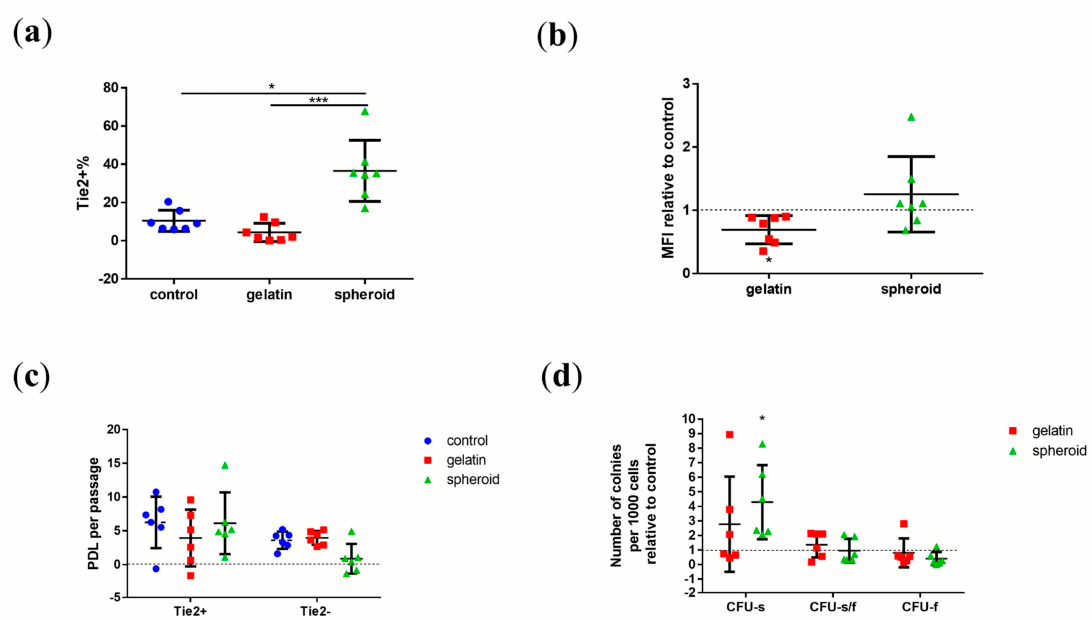
Figure 3. Plot of individual values of Tie2+ cells’ yield in the human NPC population. ( a ) Tie2-PE median of fluorescence intensity (MFI) of living single NPCs relative to control; ( b ) population doubling level (PDL) of Tie2+ NPCs and Tie2- NPCs; ( c ) and quantification of number of CFUs with resuspended NPCs relative to control in different flask types, ( d ) Number of clones with cells ≥ 10 cells per 1,000 cells seeded in methycellulose medium after ten days. Here, “control” represents cells cultured in “standard” T75 flasks, “gelatin” represents cells cultured in 0.1% gelatin-coated T75 flasks, and “spheroid” represents cells from the spheroid forming assay in ultra-low attachment T75 flasks, “number of clones relative to control” represents the number of clones formed per 1000 cells of the cells cultured in gelatin/spheroid group relative to control group; N (donors) = 7 in ( a , b ), and N = 6 in ( c , d ). Kruskal–Wallis signed-rank test with Dunn’s multiple comparison test. p = 0.0422 (a, control vs. spheroid), 0.0005 (a, gelation vs. spheroid), 0.028 ( b ), 0.0308 ( d ). * = p -value < 0.05, *** = p -value < 0.001. Lines in ( a – d ) represent means ± standard deviation (SD).